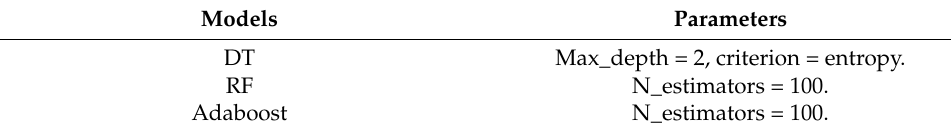
Table 4. Specification of the parameter for DT model, RF model, and Adaboost model.